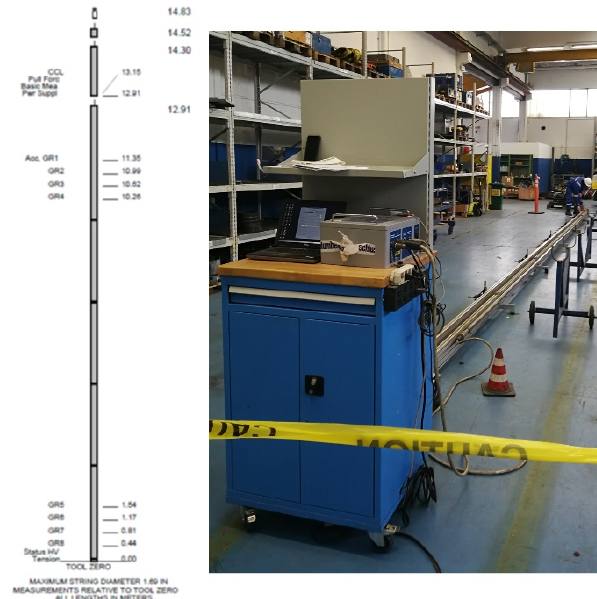
Figure 2. The FSMT logging tool.